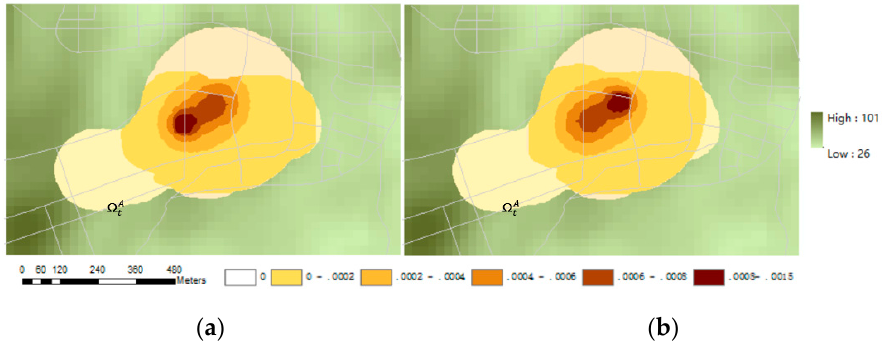
Figure 11. Probability map of A meeting B ( a ) and that of B meeting A ( b ) without considering the obstacle factor.